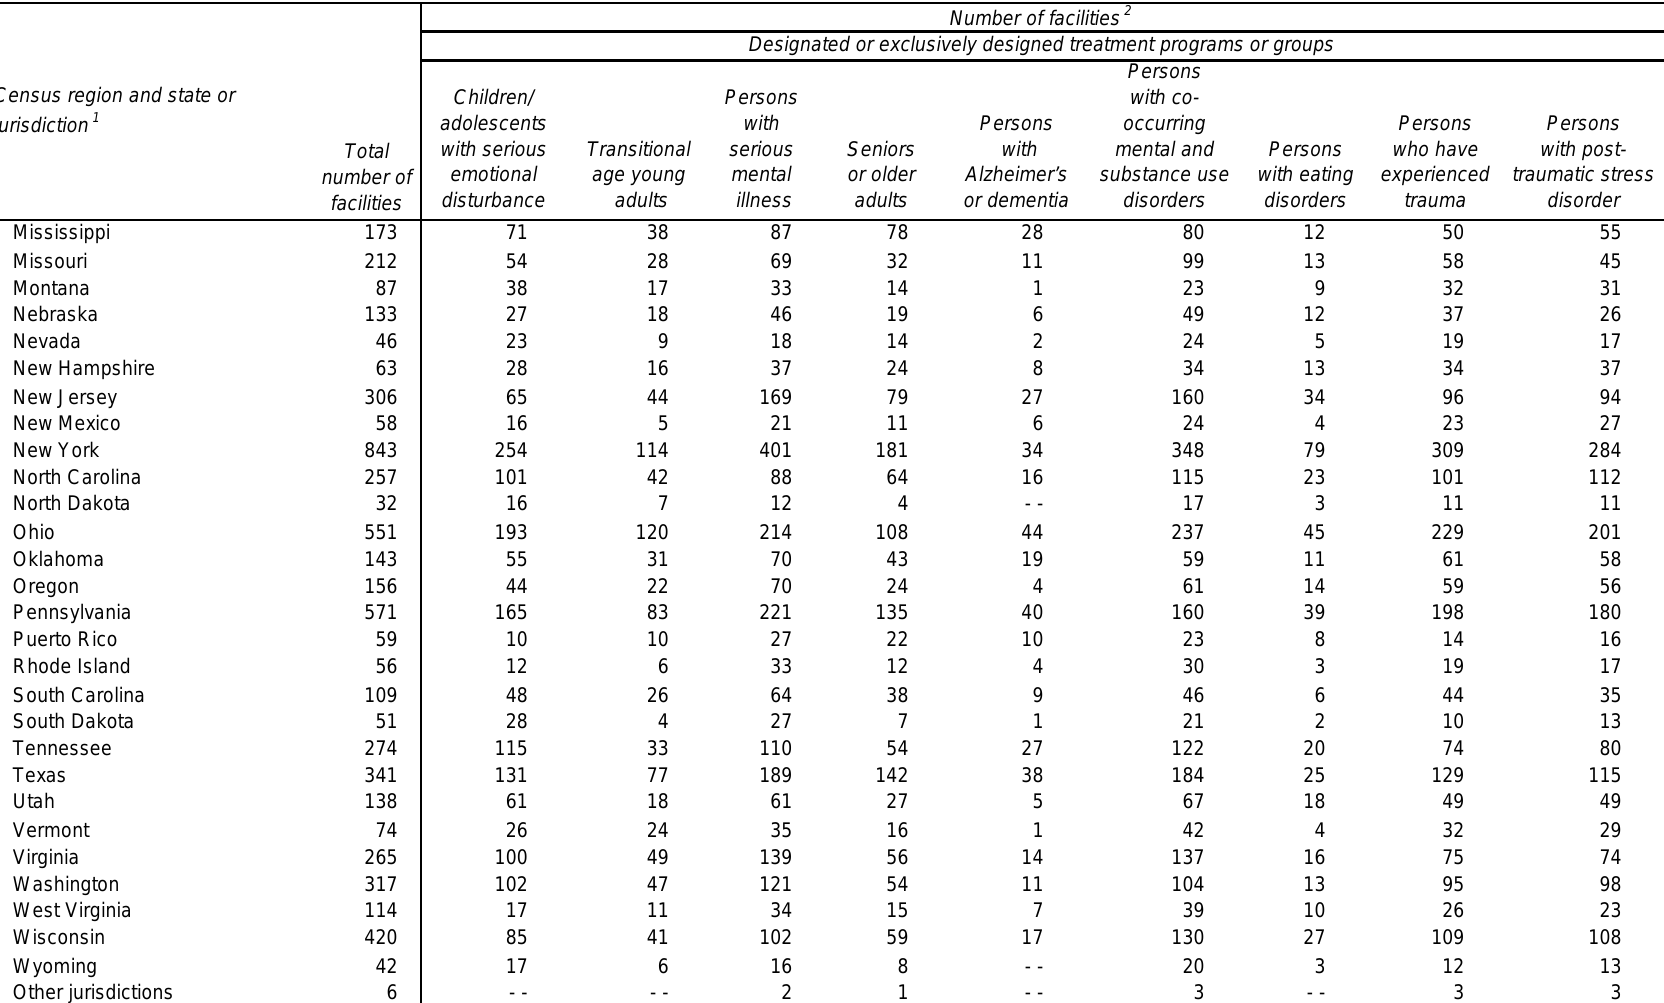
Table 3.10a. Mental health treatment facilities offering treatment programs or groups designated or designed exclusively for specific client categories,